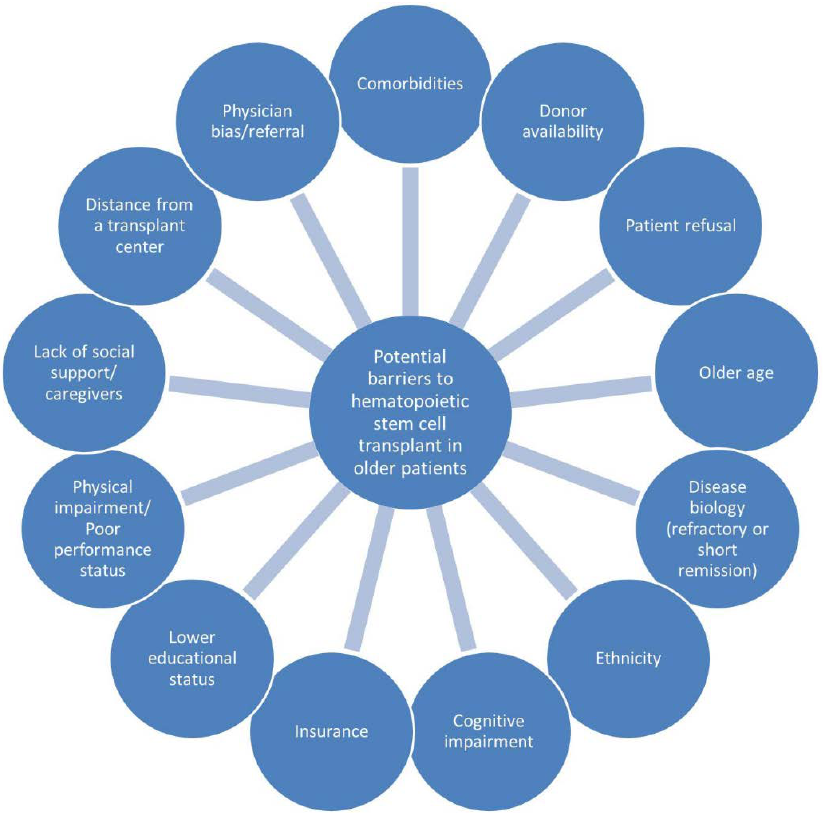
Figure 1 . Potential barriers to hematopoietic stem cell transplantation in older patients. Figure 1. Potential barriers to hematopoietic stem cell transplantation in older